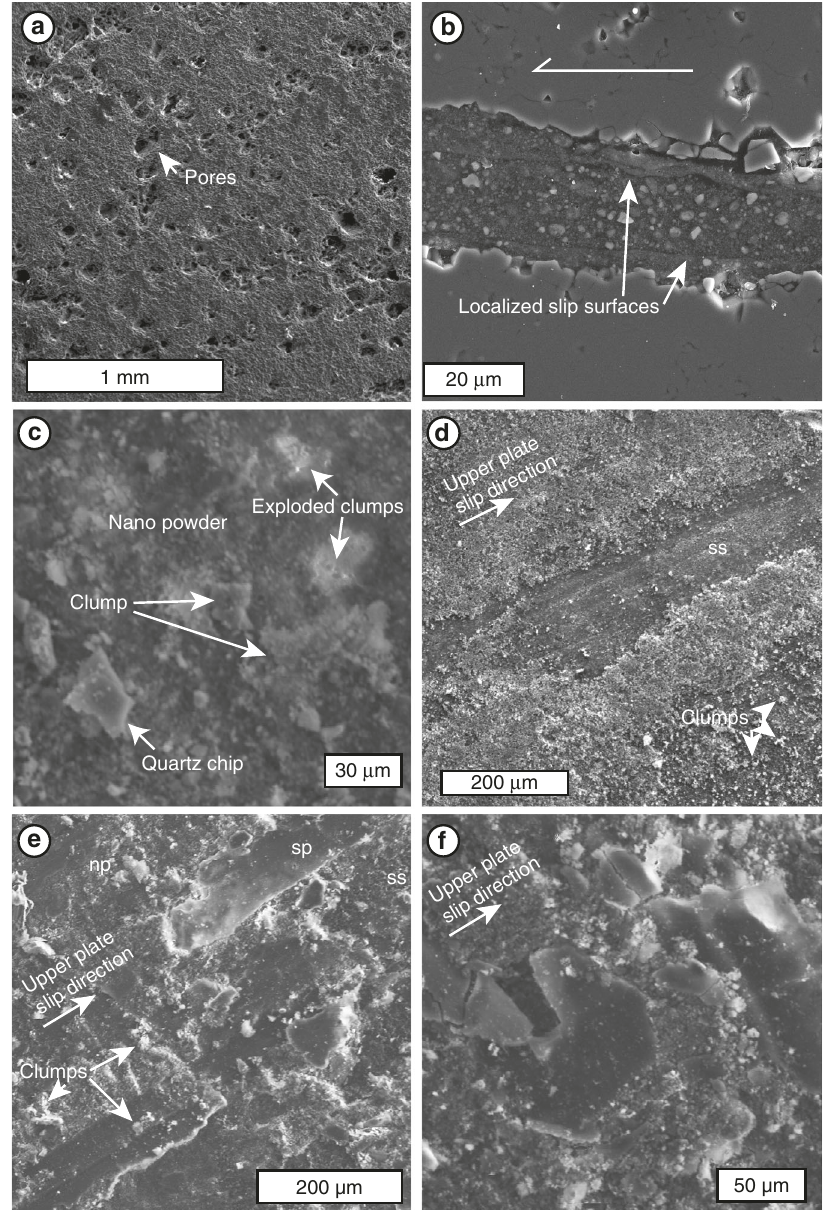
Fig. 3 Secondary electron images of microstructures in novaculite and wear material, collected with JEOL 8900 microprobe at McGill University (beam current = 20 kV). Images a and c – f are of experiment 97. Image b is of experiment 101. a Surface of unsheared novaculate (starting material) with empty (100 µ m) pores. b Cross-sectional view of wear material layer. White arrows indicate thin slip zones composed of compressed powder. c View normal to slip surface (ss) that was opened by separating novaculite cores. Clumps of ellipsoidal powder grains decorate surface and adhere to striated slip surface. Uneven distribution of wear material leaves exposed patches of slip surface with remaining 10 µ m pores. d Nanopowder (np) compressed into striated plates (sp) parallel to slip direction. e Broken fragments of striated plates, interlayered with nanopowder, displaying development and cataclasis of multiple slip surfaces during single shear experiment. f Closeup on wear powder showing quartz chips, 10 µ m clumps, and 1 µ m particles. Bright clusters show